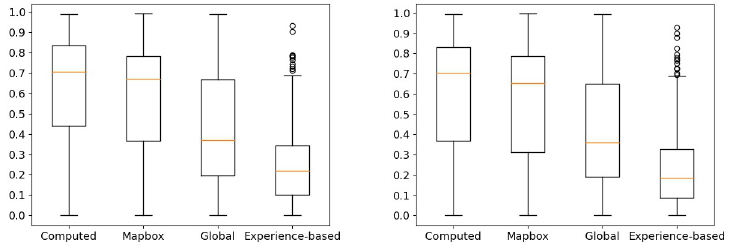
Fig 8. Box-plots of the distance between the experienced tracks and the four other types of